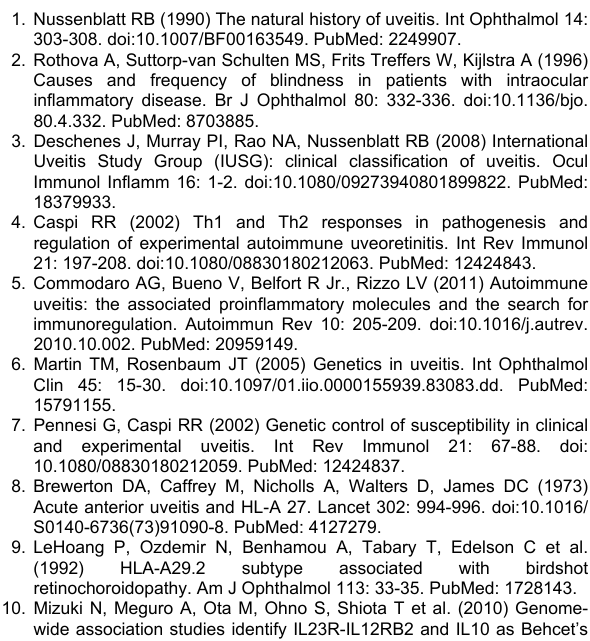
Conditional logistic regression analysis for rs2004640 and rs10954213 IRF5 genetic variants.